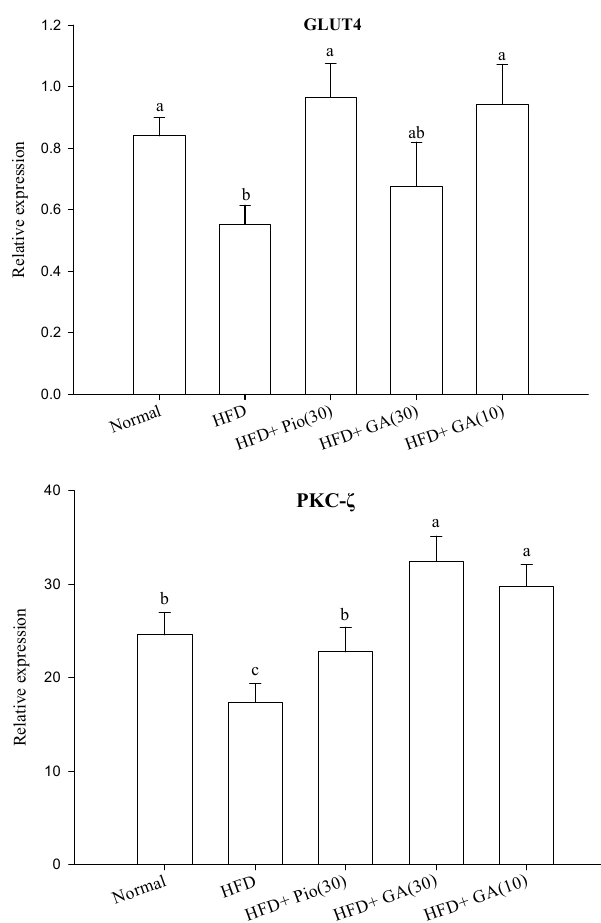
Figure 2. Effect of GA on the expression of insulin signal transduction-related proteins ( A ) insulin receptor (IR) and GLUT4, and ( B ) PKC- ζ in adipose tissues of HFD rats. GA: gallic acid; IR: insulin receptor; GLUT4: glucose transporter 4; PKC- ζ : protein kinase C-zeta; Normal: rats fed a normal diet; HFD: rats fed a 66% fructose diet; HFD + Pio (30): rats fed a 66% fructose diet and orally administered pioglitazone (30 mg/kg body weight); HFD + GA (30): rats fed a 66% fructose diet and orally administered GA (30 mg/kg body weight); HFD + GA (10): rats fed a 66% fructose diet and orally administered GA (10 mg/kg body weight). Different letters (a–c) indicate a significant difference at p < 0.05. Values calculated as the means ± SD for six rats in each group. The relative expressions of IR, GLUT4, and PKC- ζ in each treatment group were calculated using α -tublin as the standard. 2.3. Effect of GA on Carbohydrate Metabolism and Lipid Metabolism in the Perirenal Fat of HFD Rats HFD rats exhibited a 49.4% decrease in phosphofructokinase (PFK) expression as compared with the normal group ( p < 0.05) (Figure 3A). Treatment with 10 or 30 mg/kg body weight GA significantly increased PFK expression by 208.3% and 99.6%, respectively, in HFD animals ( p < 0.05) (Figure 3A). The expression of pyruvate kinase (PK) was suppressed by 80.0% in this group ( p < 0.05) (Figure 3A). HFD rats administered 10 and 30 mg/kg body weight GA had restored PK expression, by 91.1% and 83.7%, respectively ( p < 0.05) (Figure 3A). The rats fed with HFD also had a 71.6% decrease in expression of adipose triglyceride lipase (ATGL), which was enhanced by 171.6% in HFD rats treated with 30 mg/kg body weight GA ( p < 0.05) (Figure 3B).